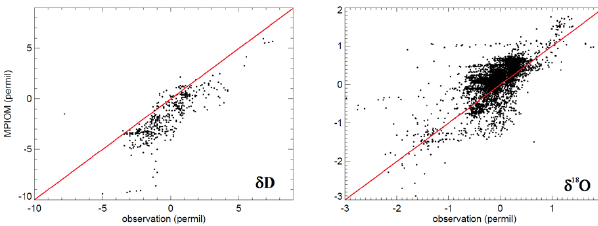
Fig. 6. Comparison of observed water isotopic values (averaged onto the MPIOM model grid) versus modelled isotopic values be- tween 100m and bottom. The 1:1 line is colored in red.